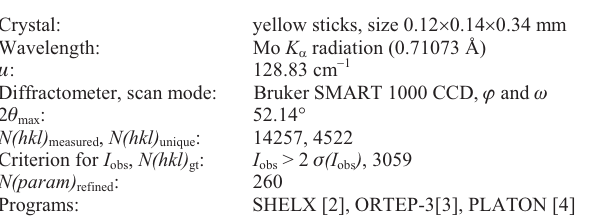
Table 1. Data collection and handling.